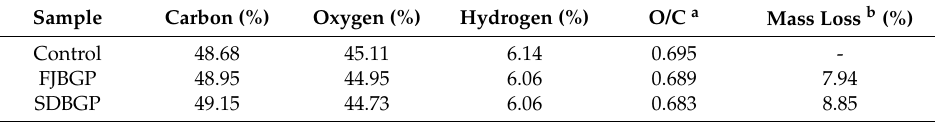
Table 2. Elemental composition and mass loss of used BGP and control